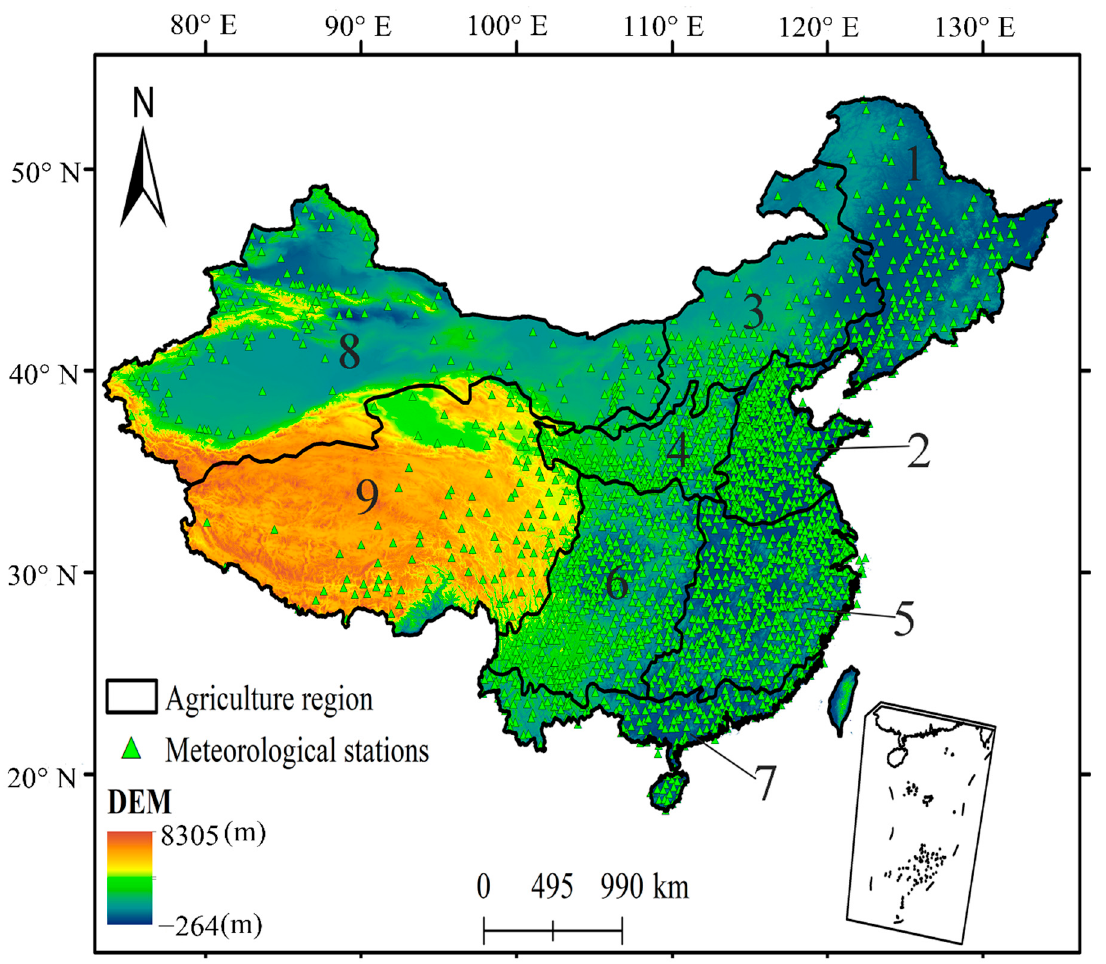
Figure 1. Spatial distribution of Chinese agricultural regions and the 2417 meteorological stations. The different codes represent different regions: 1—Northeast China Region (NECR), 2—Huang-Huai-Hai Region (HHHR), 3—Inner Mongolia and the Great Wall Region (MGR), 4—Loess Plateau Region (LPR), 5—middle and lower regions of the Yangtze River (YRR), 6—Southwest China Region (SWCR), 7—South China Region (SCR), 8—Gan-Xin Region (GXR), 9—Qinghai-Tibet Plateau Region (QTR).